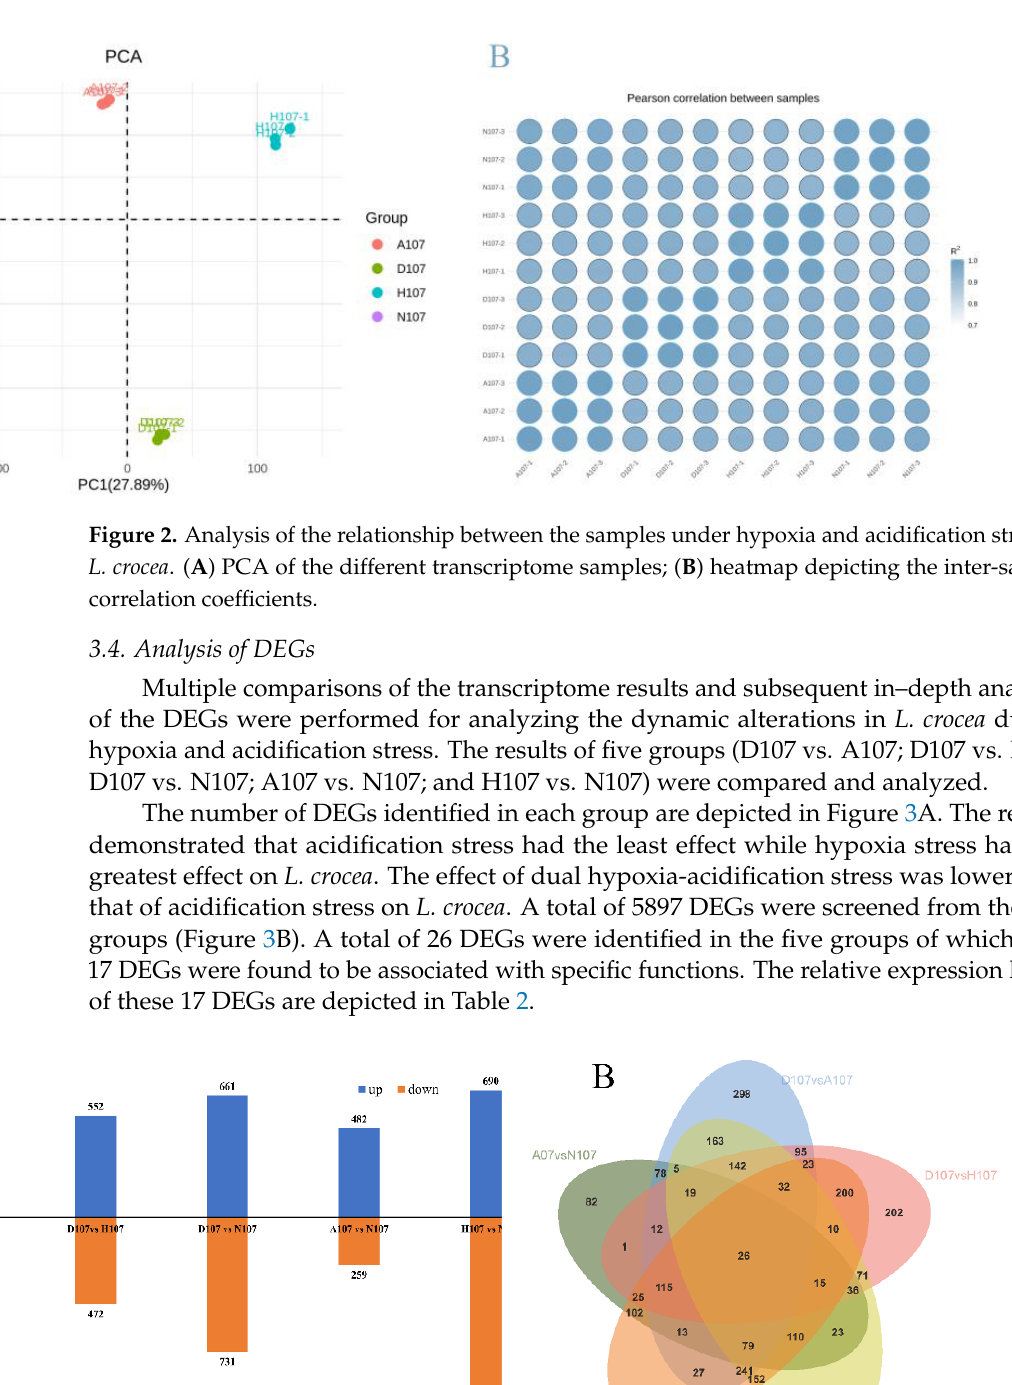
Figure 3. Number of DEGs under hypoxia and acidification stress in L. crocea depicted using ( A ) a histogram and ( B ) a Venn diagram.